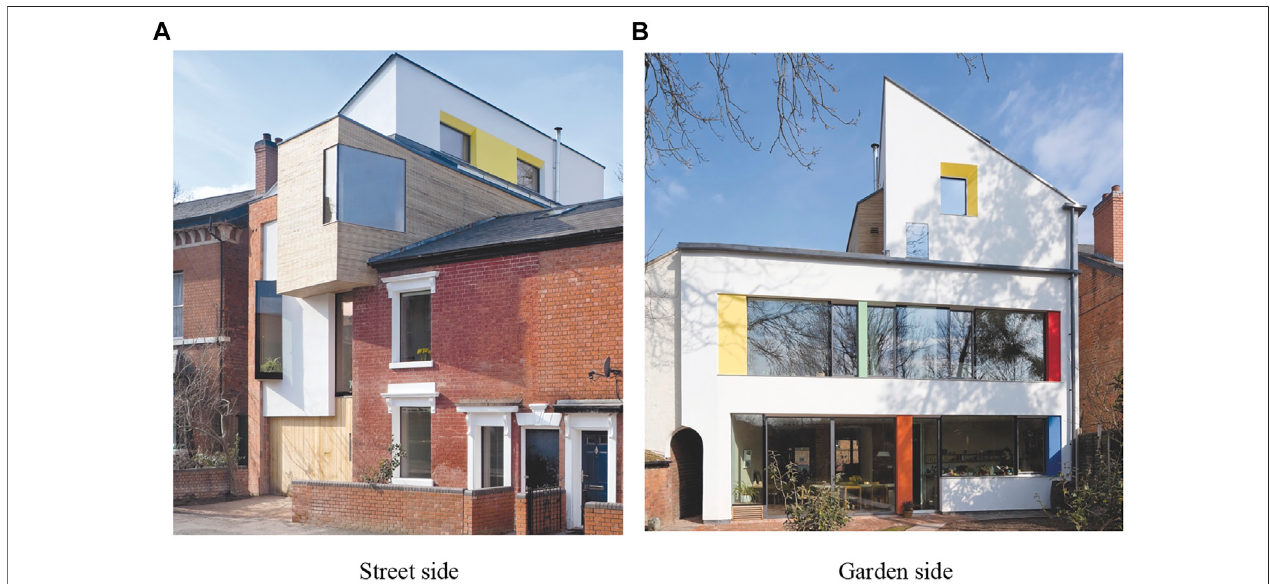
FIGURE 2 | Birmingham Zero Carbon House (photos with permission from Martine Hamilton Knight/STO).